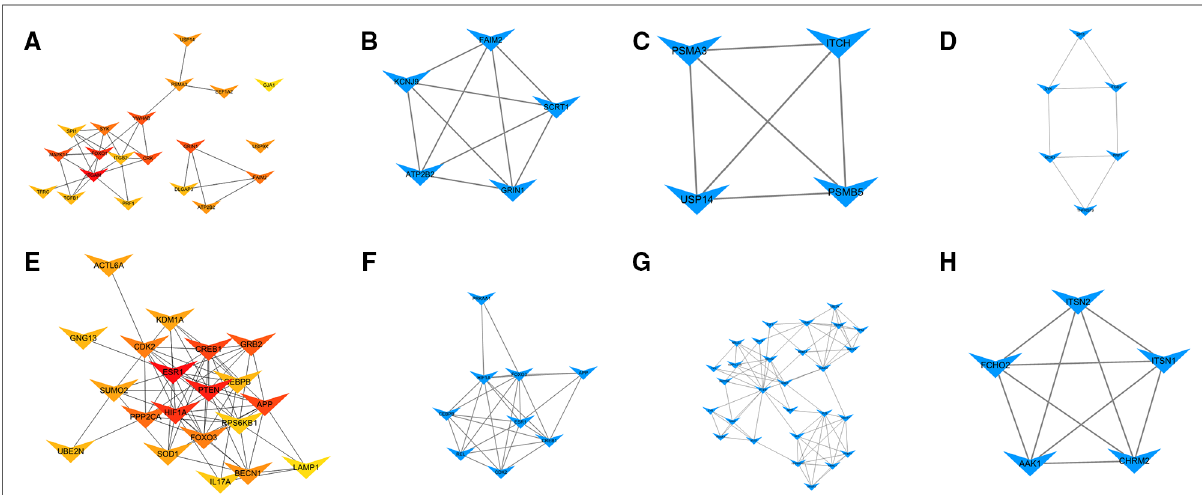
FIGURE 5 Hub genes and modules analysis. ( A ) PPI for the top 20 ranked hub genes for upregulated DEmiRNAs. ( B ) Module 1, ( C ) Module 2, and ( D ) Module 3 for target genes of upregulated DEmiRNAs. ( E ) PPI for the top 20 ranked hub genes for downregulated DEmiRNAs. ( F ) Module 1, ( G ) Module 2, and ( H ) Module 3 for target genes of downregulated DEmiRNAs.